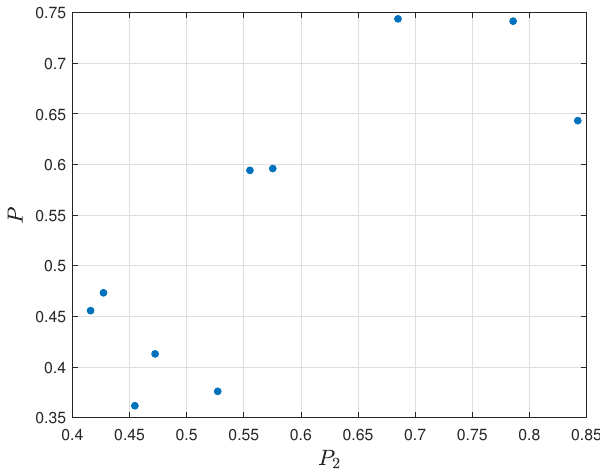
Figure 20. The relation diagram of the Frag gaining assessment ( P 2 ) for final assessment P